Question: Write the caption for this figure.
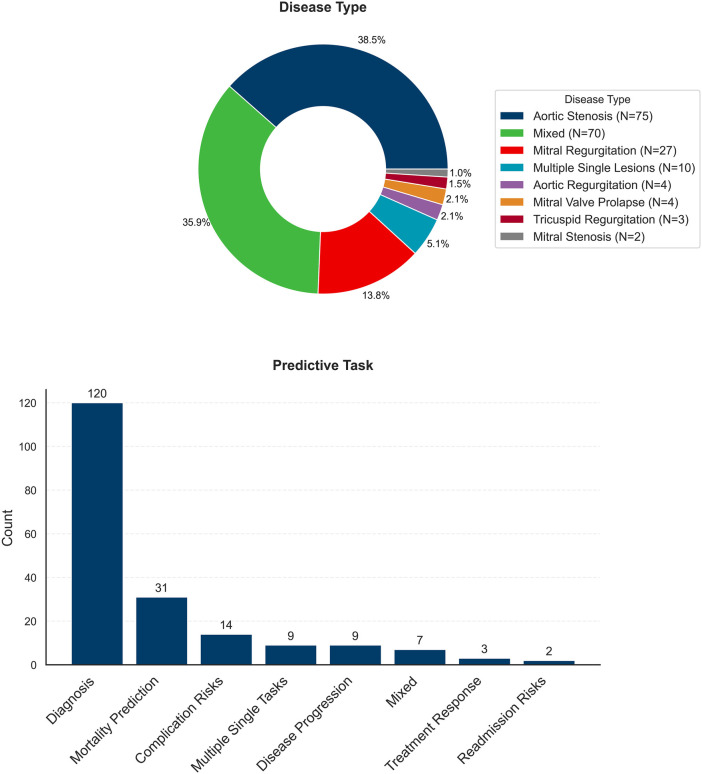
Answer: Distribution of studies based on VHD type and predictive task. “Mixed” denotes models trained to address multiple diseases or predictive tasks using a single unified model; “Multiple” refers to separate, single-lesion or task-specific models each addressing distinct VHD or predictive task respectively.